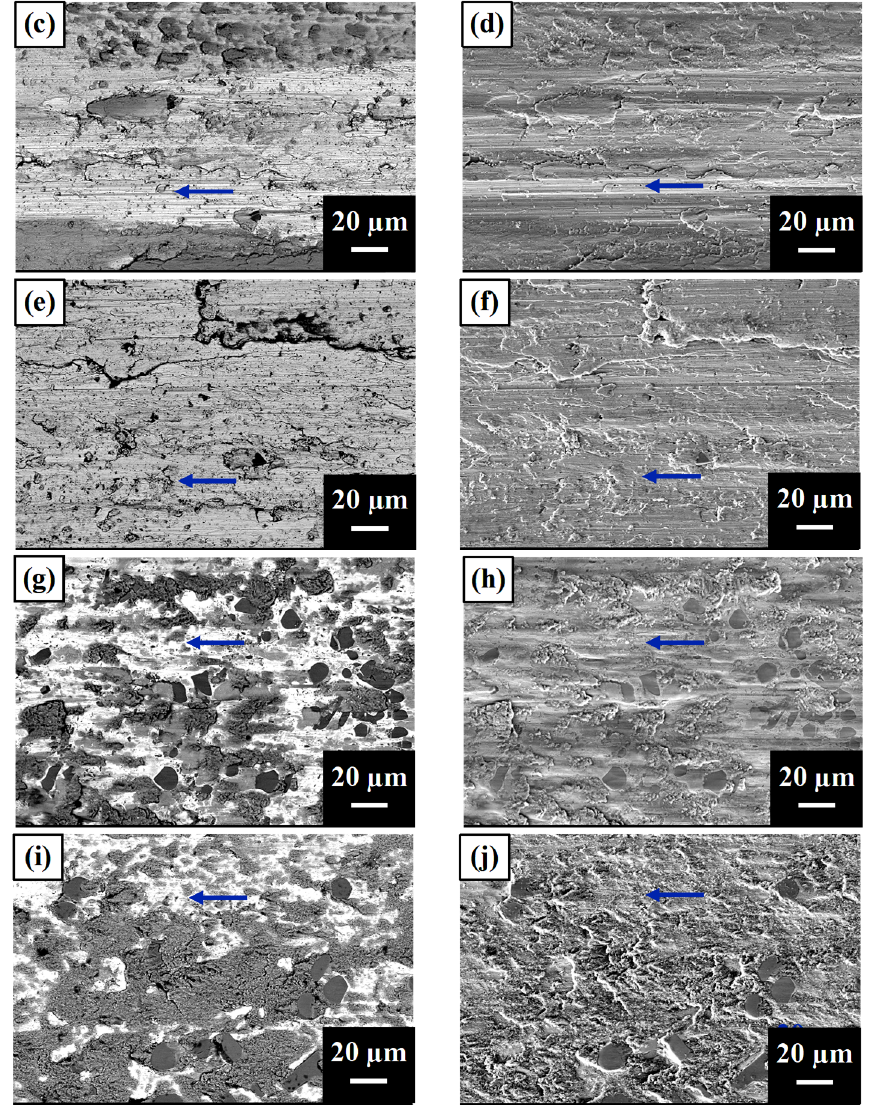
Figure 6. SEM images of worn surfaces of ( a ) A1 BEI, ( b ) A1 SEI, ( c ) A2 BEI, ( d ) A2 SEI, ( e ) A3 BEI,